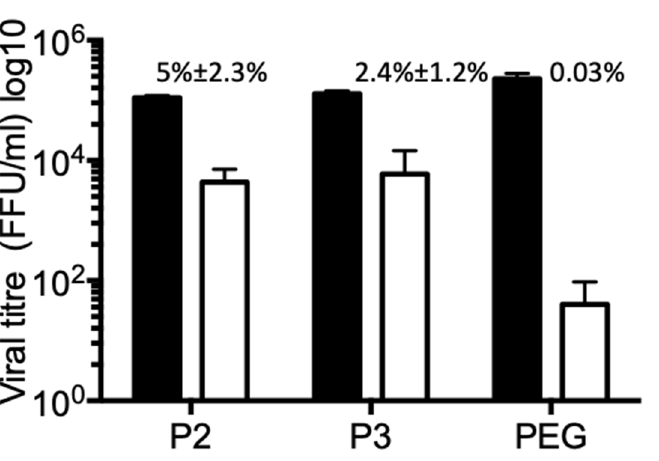
Figure 6. Viral particles associated with extracellular vesicles are protected from antibody neutralization. Caco-2 cells were infected with strain RRV (MOI of 1), and 18 hpi the supernatant was collected. Di ff erent fractions were obtained by di ff erential centrifugation as described in material and methods; P2 at 2000 × g , P3 at 9600 × g and PEG fraction after PEG6000 addition. All pelleted fractions were resuspended in 100 µ L of TNC, and an aliquot of the fraction was diluted 1 / 10 in MEM without serum. The diluted samples were divided into three equal aliquots, and subjected to incubation for 1 h with MEM (black bars), or neutralization with nMAb159 (open bars). Additionally, the membrane was solubilized by 0.1% Triton X-100 followed by neutralization by nMab159. After treatment with Triton X-100, the detergent was removed using HiPPR TM Detergent Removal Columns. Then, the mixture was added to washed MA104 cells for 2 h to allow the virus cell entry, and the unbound vesicles were then removed by two rounds of washing. Infection was left to proceed for 15 h, and the infected cells were detected by immunostaining as described above. In fractions treated with detergent, followed by neutralization with nMab159, no infected cells were observed. The number above open bar represents percentage of infected cells after neutralization with nMAb159. Results represent the average of four independent experiments.